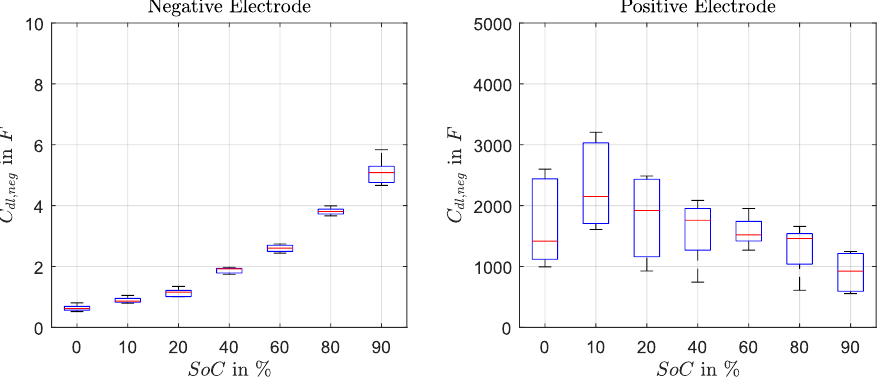
Figure A3. Determined double-layer capacity values from fitting of impedance spectra measured with discharging DC-currents (negative electrode) and from fitting of discharge pulses (positive electrode) over